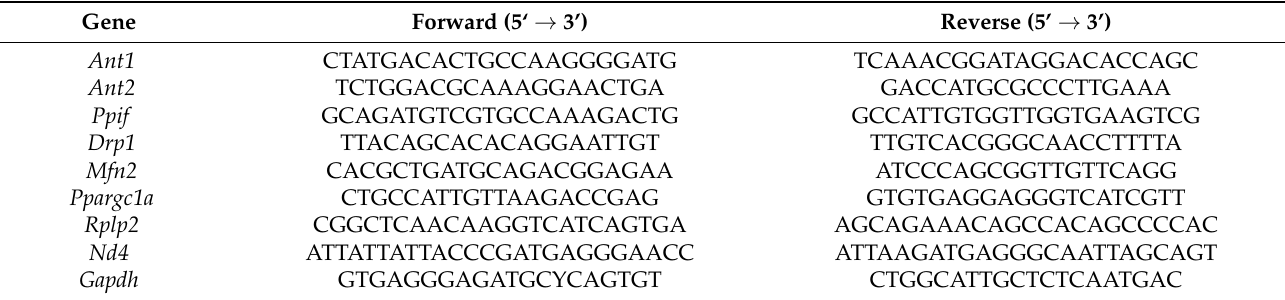
Table 2. List of gene-specific primers for RT-PCR